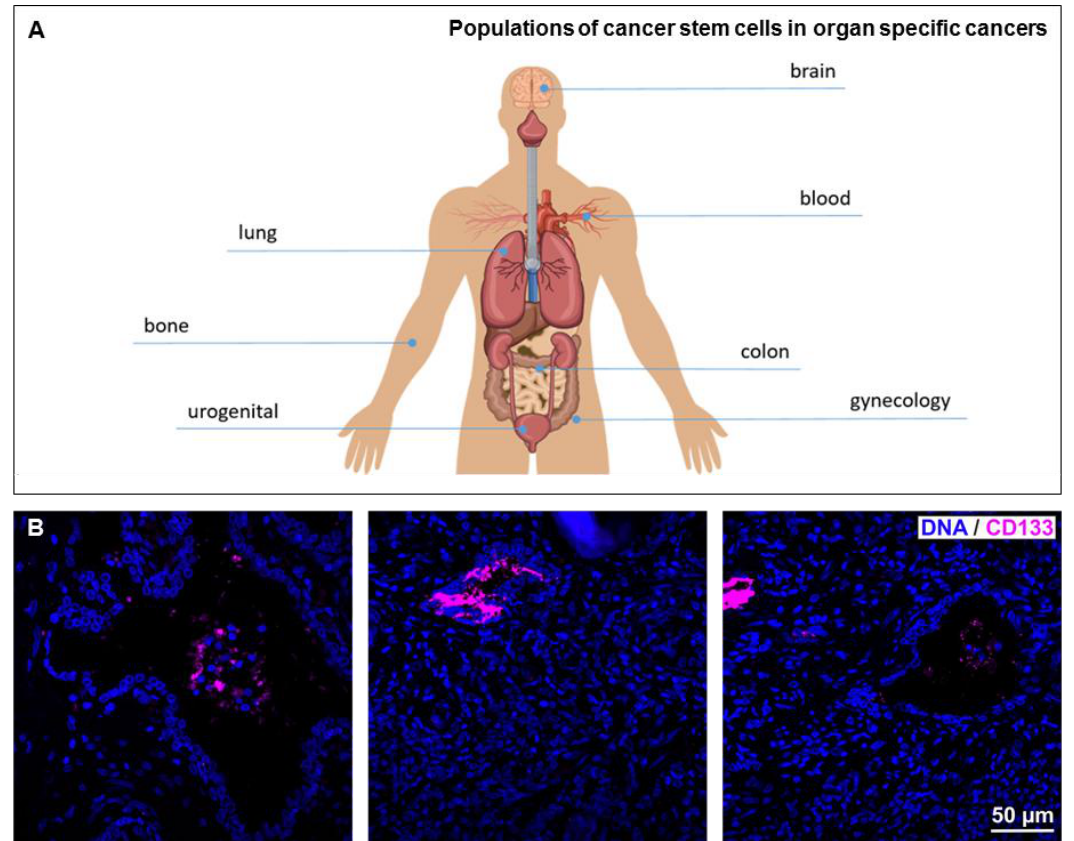
Figure 3. ( A ) Different organs can give rise to tumors containing cancer stem cells. ( B ) Prostate cancer tissue was identified by HE staining, stained with an antibody against the stem cell marker CD133 (magenta). Nuclei are stained with DAPI (blue). Prostate cancer typical single layer glands are visible in the left and right image. Note the nest-like appearance of CD 133 positive cancer stem cells within the cancerous tissue.